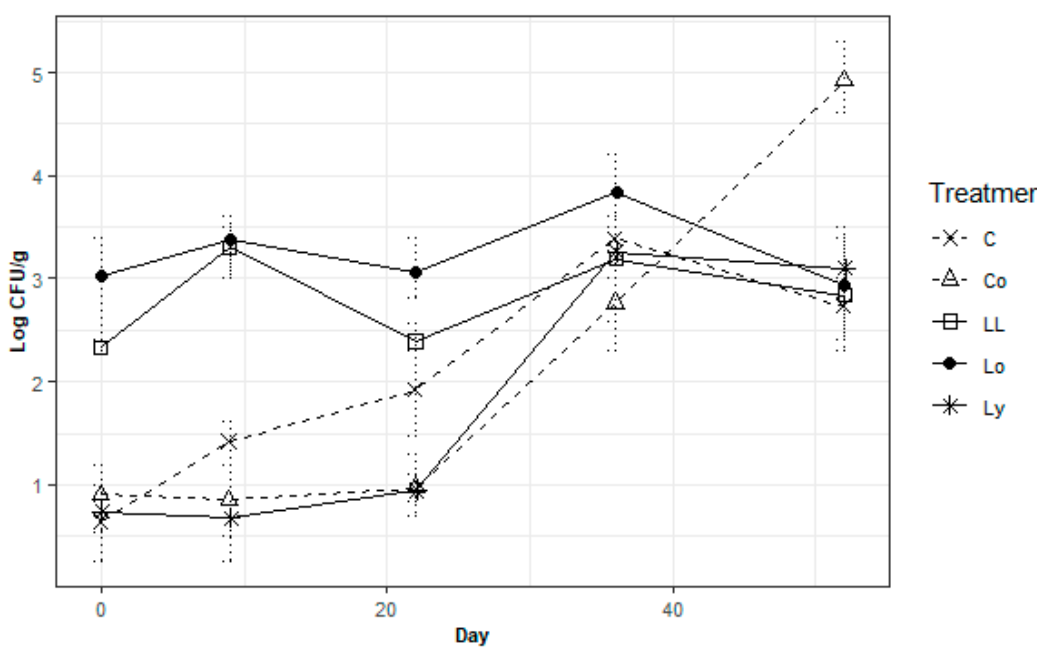
Figure 2. CFU count in soil (Treatment).